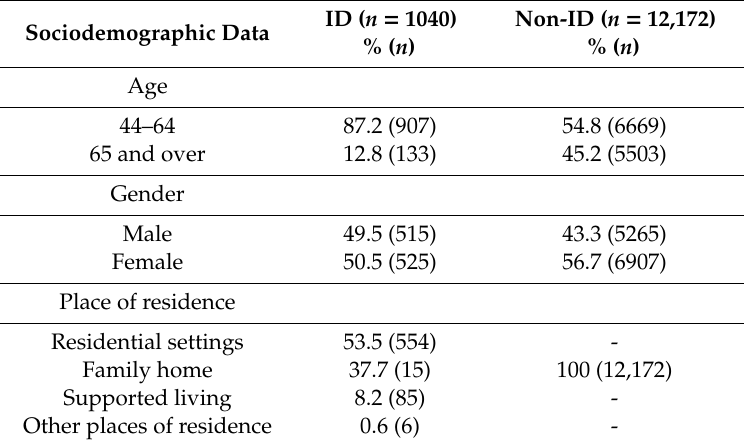
Table 1. Sociodemographic information of the participants in the study.